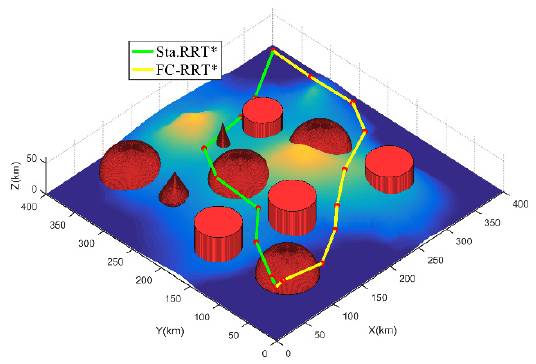
Figure 9. Path comparison of RRT* and FC-RRT* in 3D